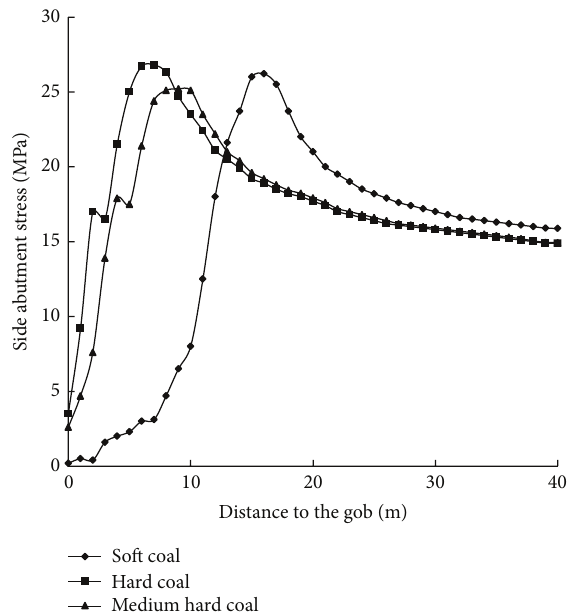
Figure6:Distributionofthesideabutmentstressforcoalofdifferent category.